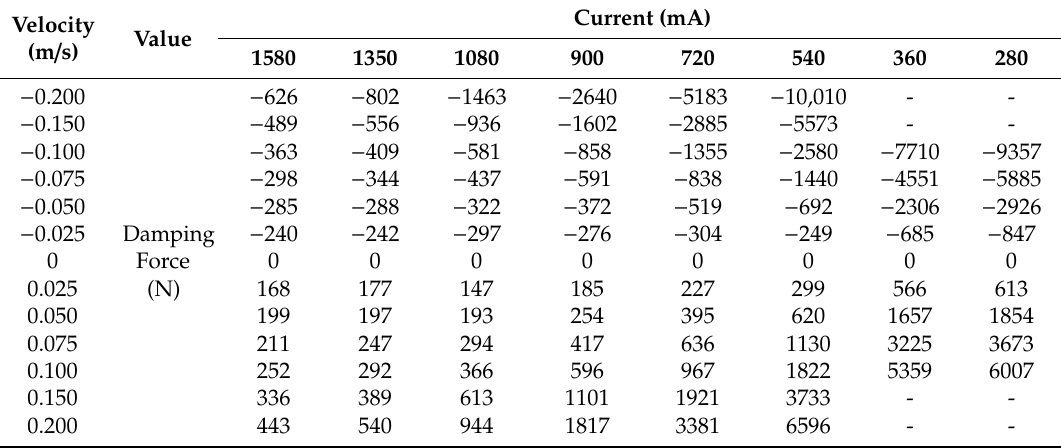
Table 5. Results of damping force for